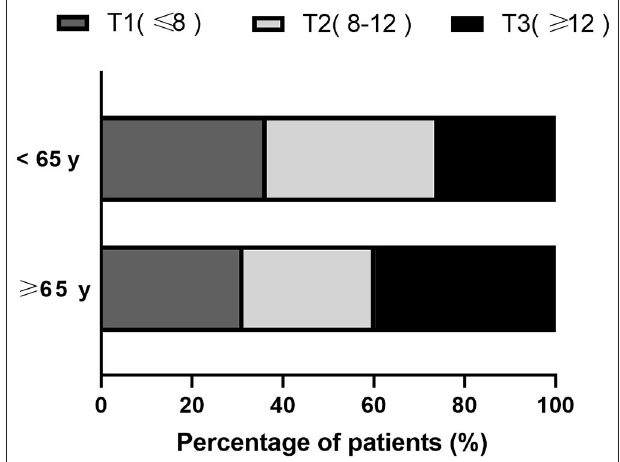
FIGURE 1 | Percentage in the subcategorized groups of age according to Hcy